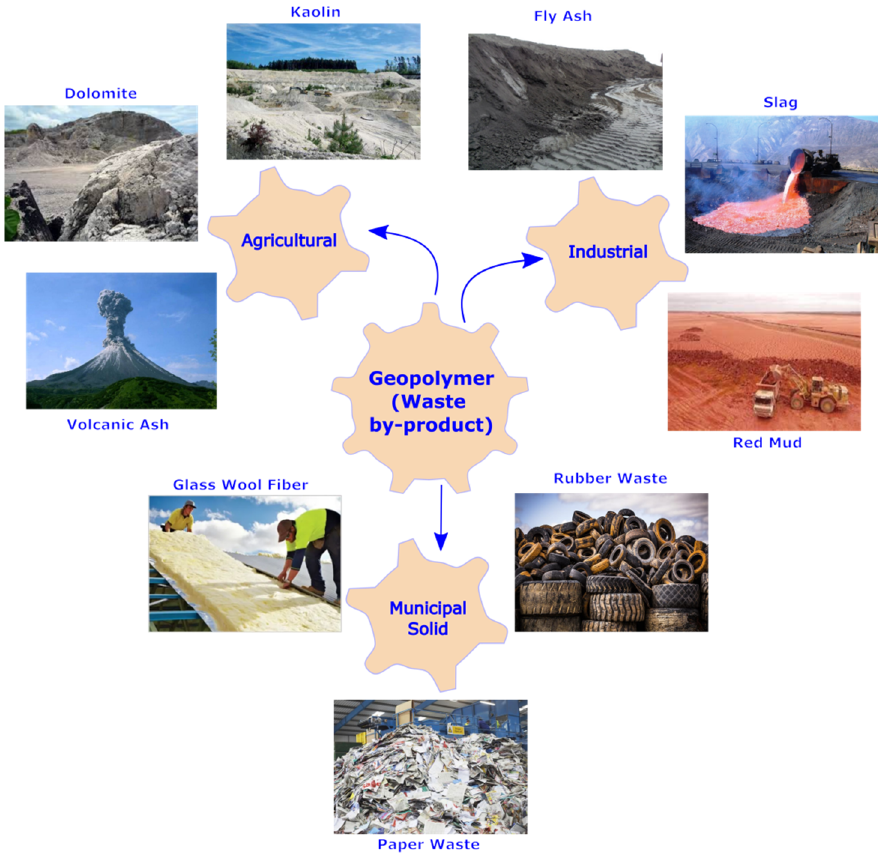
Figure 1. Common type of precursor materials used in geopolymer material.